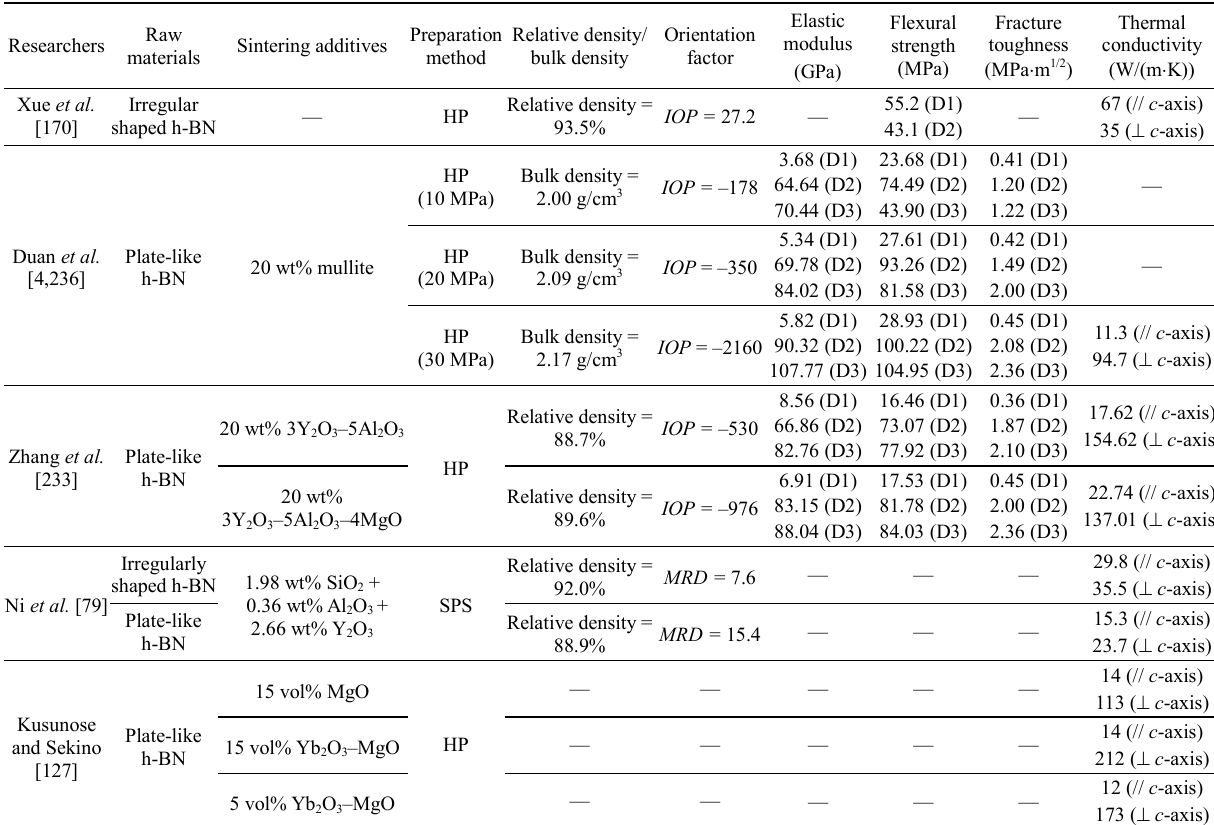
Table 8 Properties of textured h-BN matrix